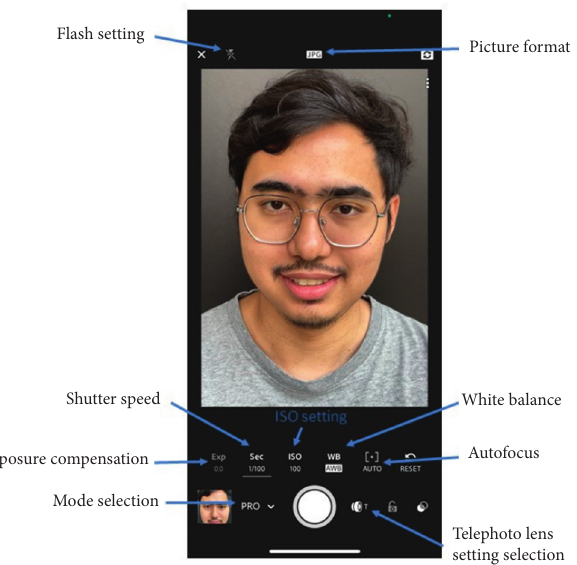
Figure 2: Example of manual